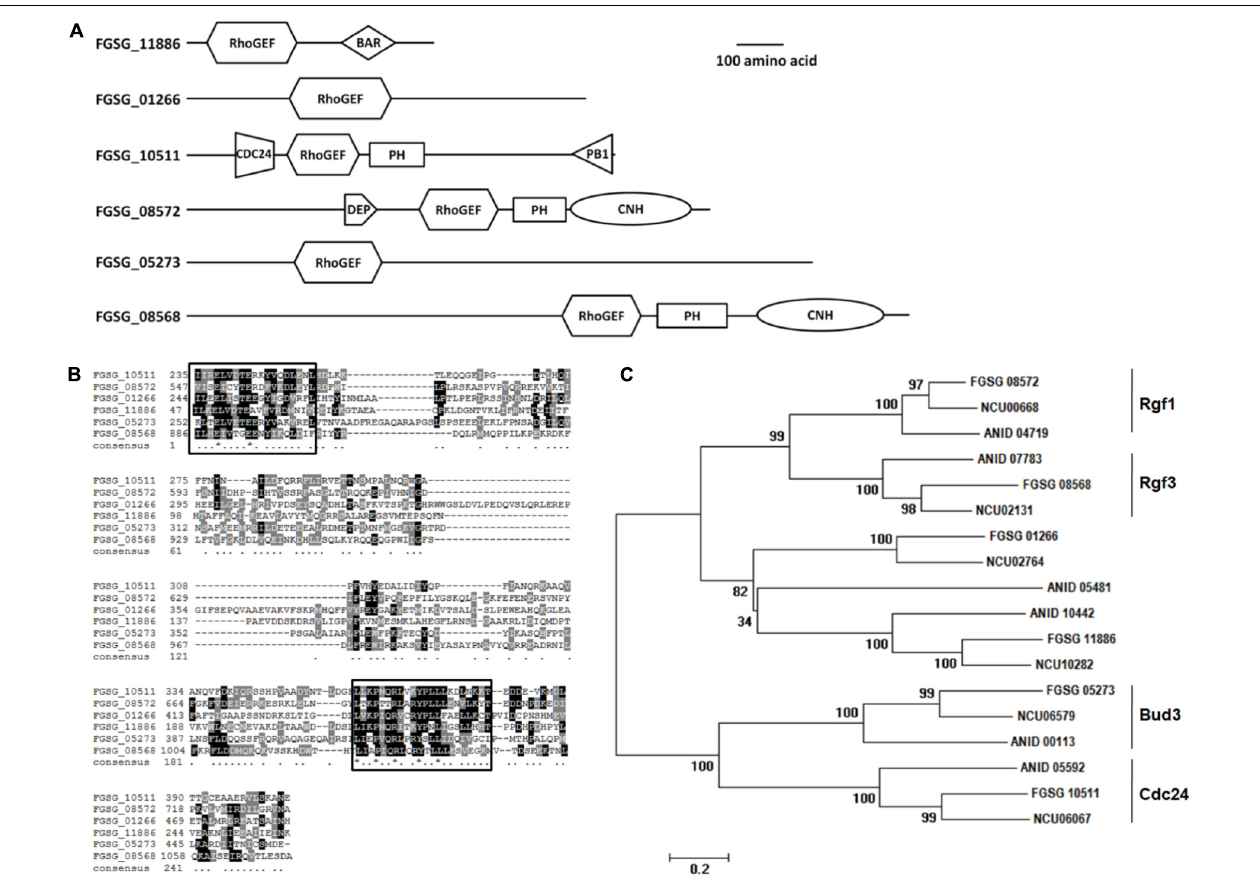
FIGURE 1 | Fusarium graminearum encodes six putative RhoGEF proteins. (A) The domain distribution of six F. graminearum RhoGEFs. (B) The RhoGEF domain amino acid sequences of six F. graminearum RhoGEFs were aligned. Residues conserved in all proteins were highlighted in black or gray shaded. The black frames showed the conserved regions. (C) Phylogenetic comparison of six F. graminearum RhoGEFs with other fungal RhoGEFs. The amino acid sequences of RhoGEFs from N. crassa (NCU), A. nidulans (ANID) and F. graminearum (FGSG) were analyzed by the Clustal X 1.83 program to create a progressive alignment dendrogram. The branch lengths were proportional to the mean number of differences per residue along each branch. Accession number of each protein was shown as follows: FGSG_08572, XP_011320178.1; NCU00668, XP_965808.3; ANID_04719, XP_662323.1; ANID_07783, XP_681052.1; FGSG_08568, XP_011320182.1; NCU02131, XP_011392943.1; FGSG_01206, XP_011317046.1; NCU02764, XP_964259.2; ANID_05481, XP_663085.1; ADID_10442, XP_661358.1; FGSG_11886, XP_011316798.1; NCU10282, XP_001728403.1; FGSG_05273, XP_011323784.1; NCU06579, XP_961939.3; ANID_00113, XP_657717.1; ANID_05592, XP_663196.1; FGSG_10511, XP_011319503.1; NCU06067,